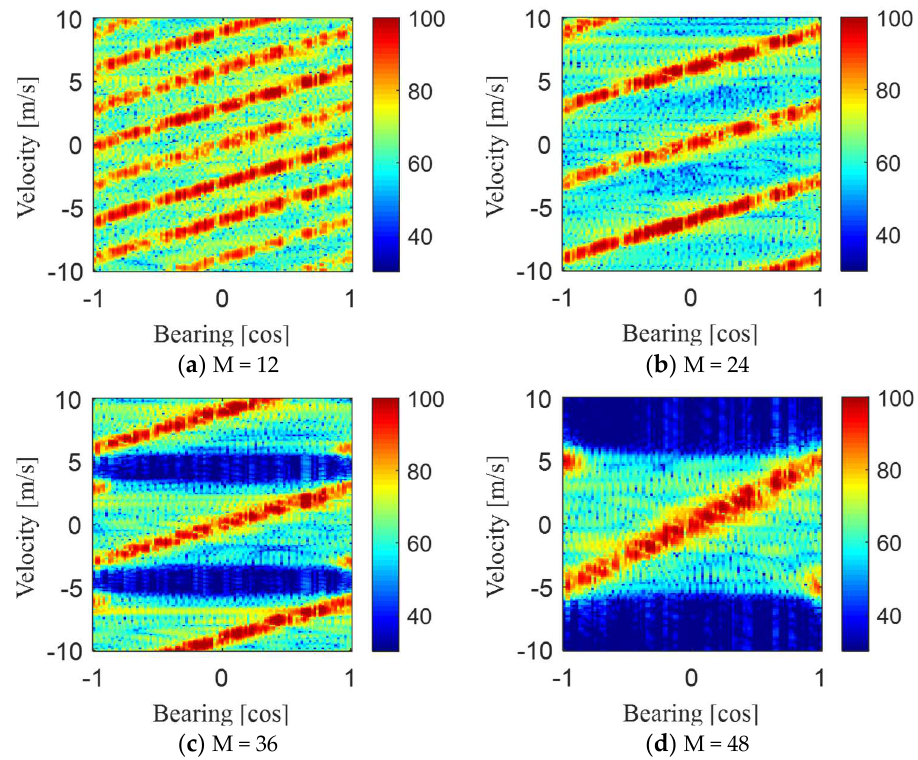
Figure 6. Speed−bearing diagram for PTFM waveform with different numbers M of sub−pulses. Figure 6. Speed–bearing diagram for PTFM waveform with different numbers M of